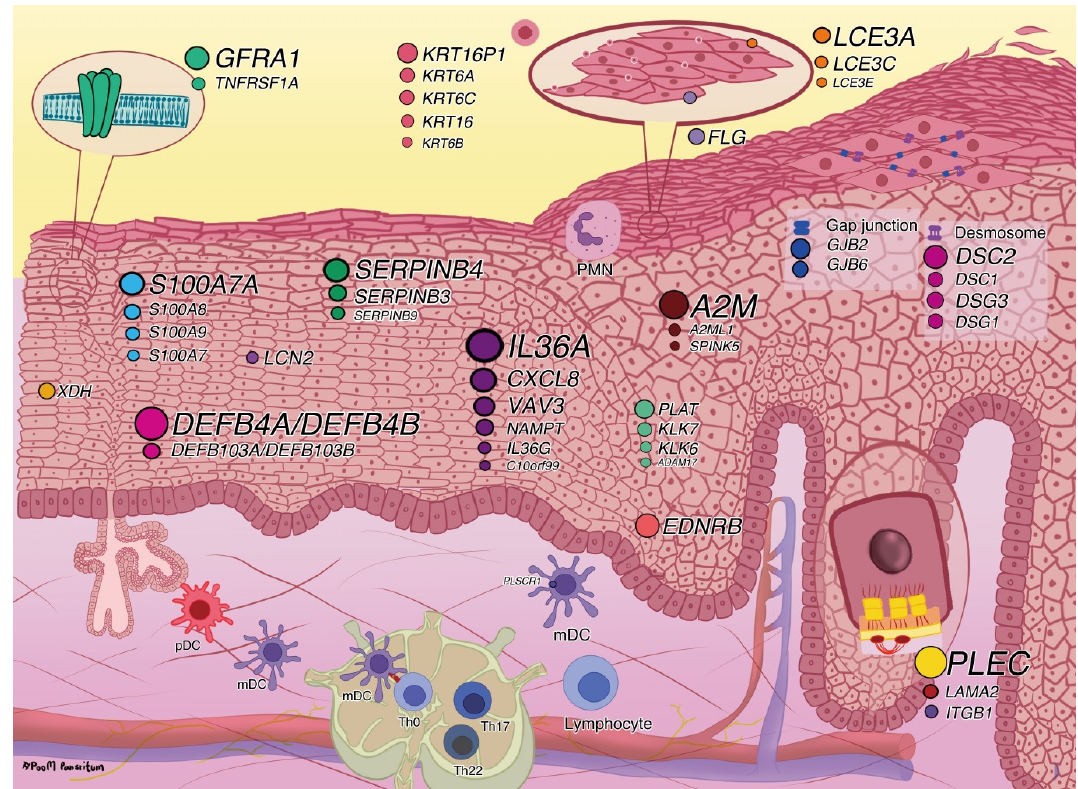
Figure 3. Potential upregulated differentially expressed genes (DEGs). The circles represent the fold change of expressed genes; the larger the circle, the more upregulated the expression of DEGs.